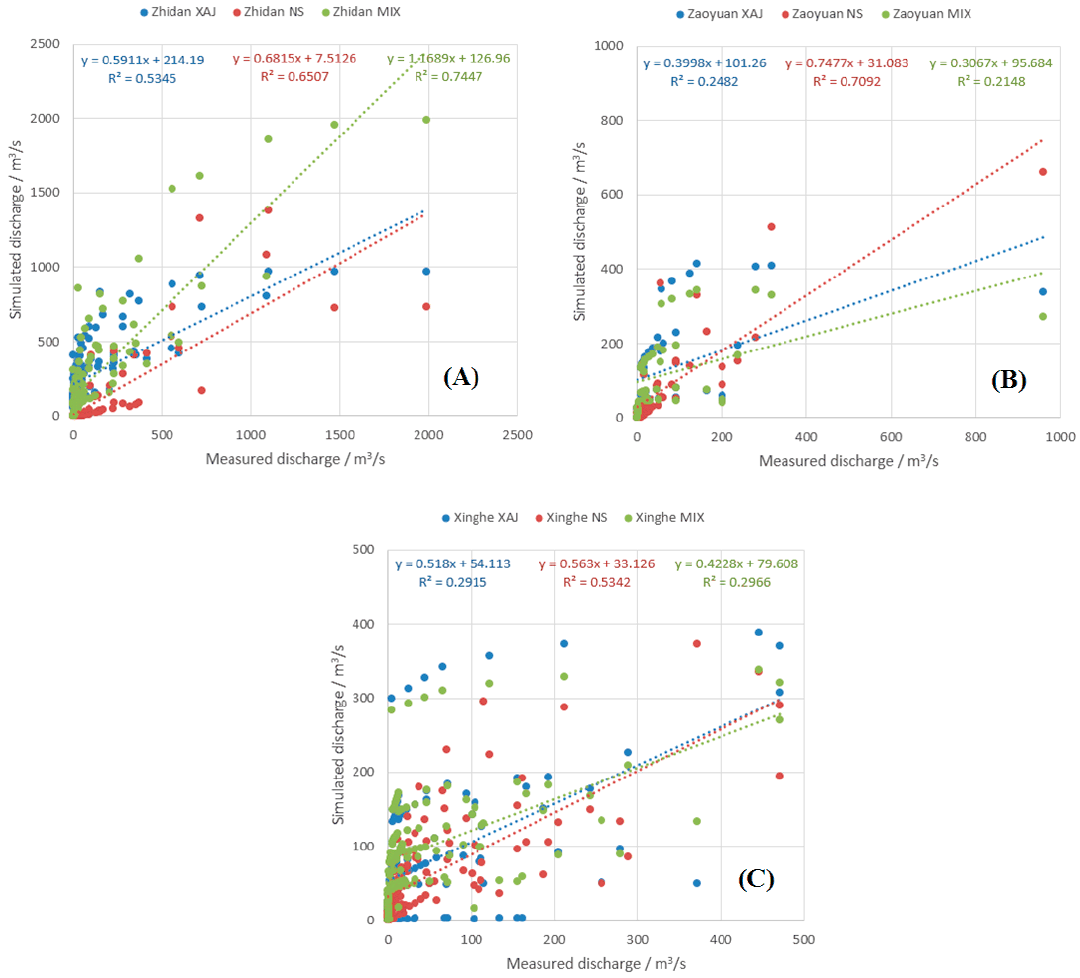
Figure 12. Scatter plots of observed and simulated discharges for arid regions; ( A ) Zhidan; ( B ) Zaoyuan; ( C ) Xinghe.